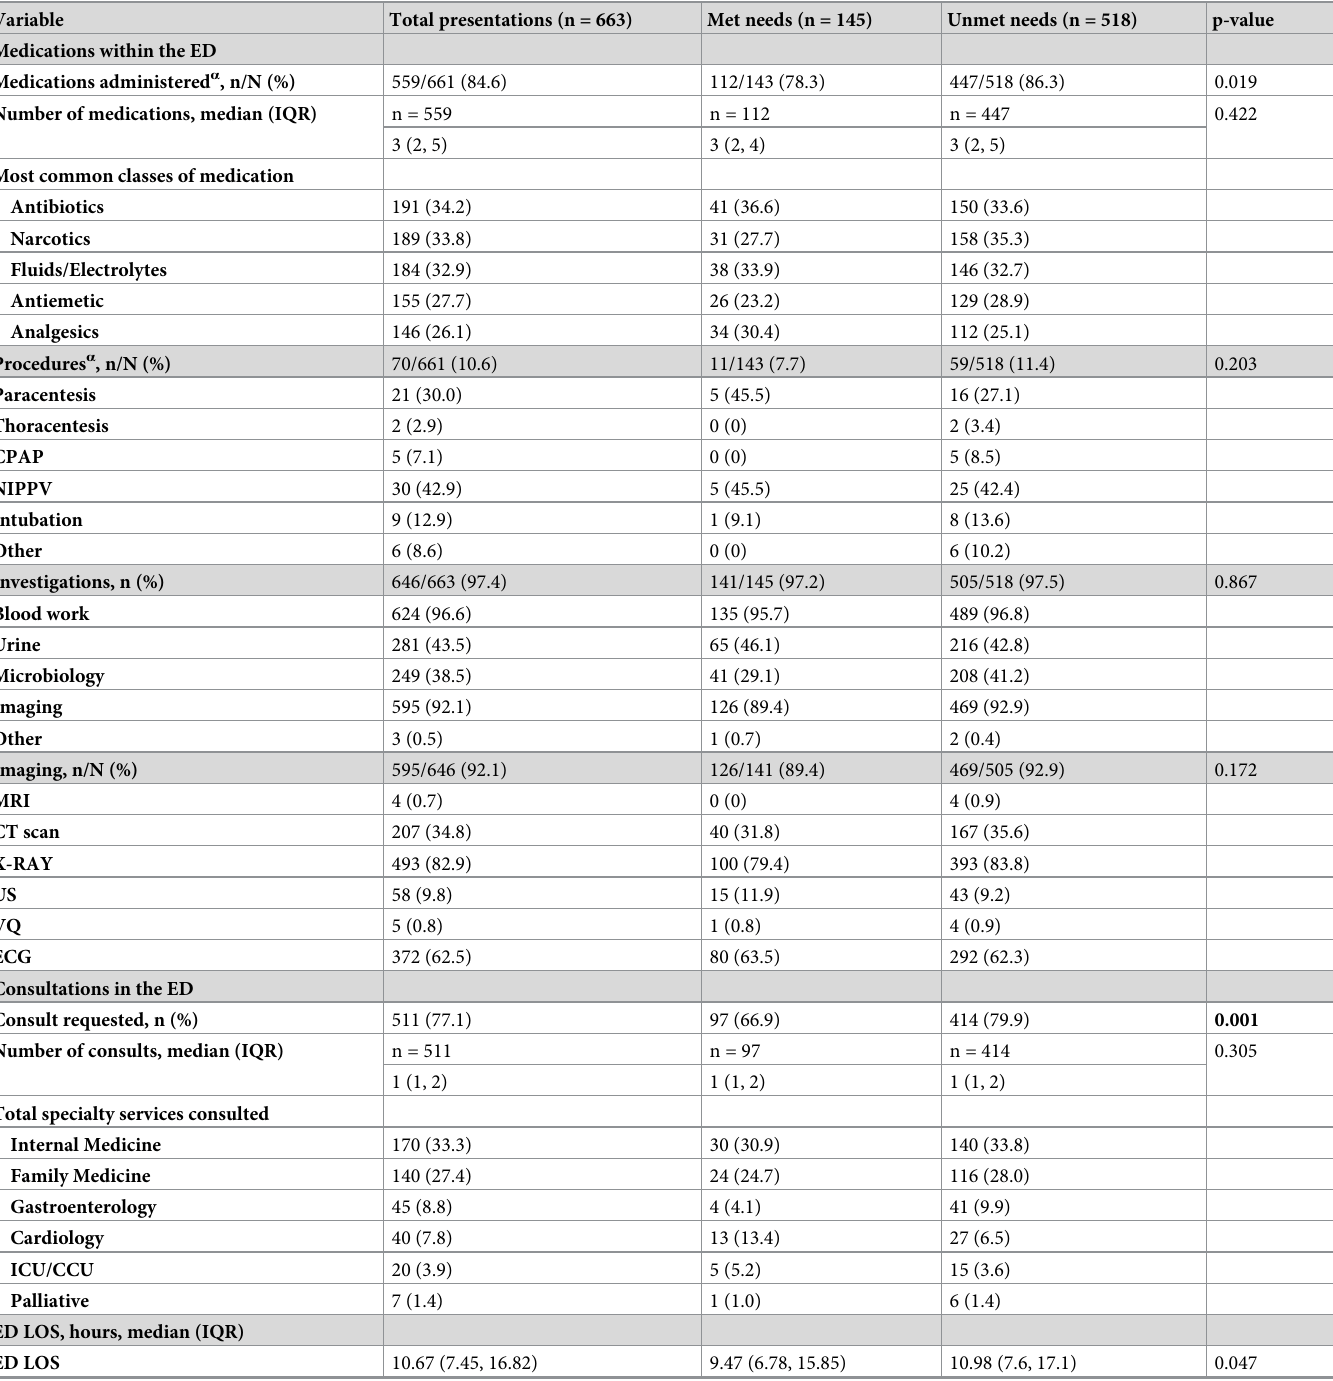
Table 3. Emergency department management of 663 presentations by patients with end-of-life conditions compared on unmet vs. met palliative care